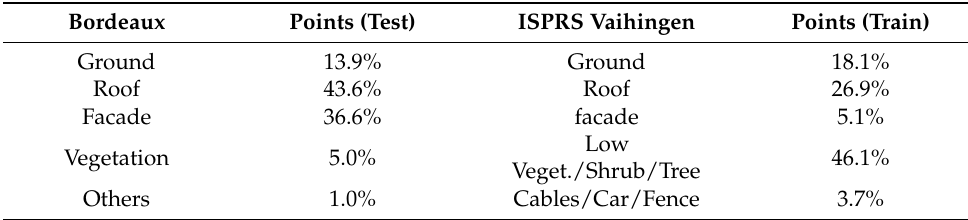
Table 20. Corresponding classes between Bordeaux and ISPRS Vaihingen datasets.